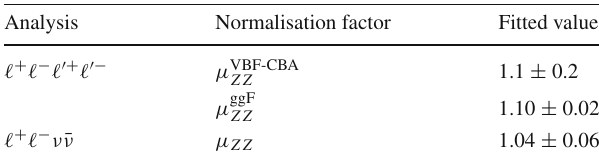
Table 6 The Z Z normalisation factors in each category of the two final states, which scale the number of Z Z events estimated from the MC simulations, obtained from a simultaneous likelihood fit of the two final states under the background-only hypothesis. For the (cid:3) + (cid:3) − (cid:3) (cid:2)+ (cid:3) (cid:2)− final state, the cut-based categorisation is used Analysis Normalisation